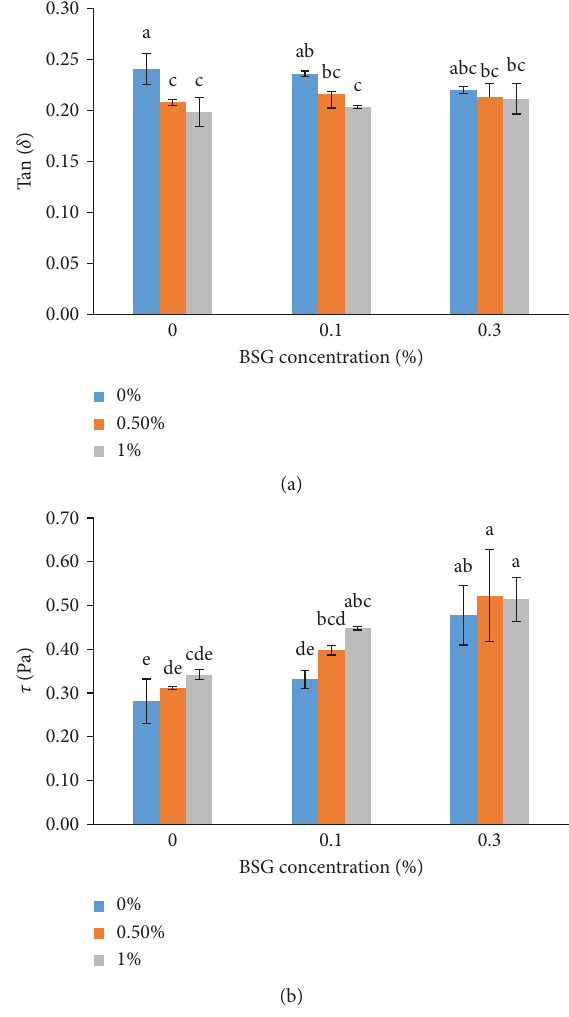
Figure 2: Effect of NaCl and basil seed gum on tan ( δ ) (b) of the foams made of egg albumin. Columns with different letters are significantly ( p < 0 . 05)